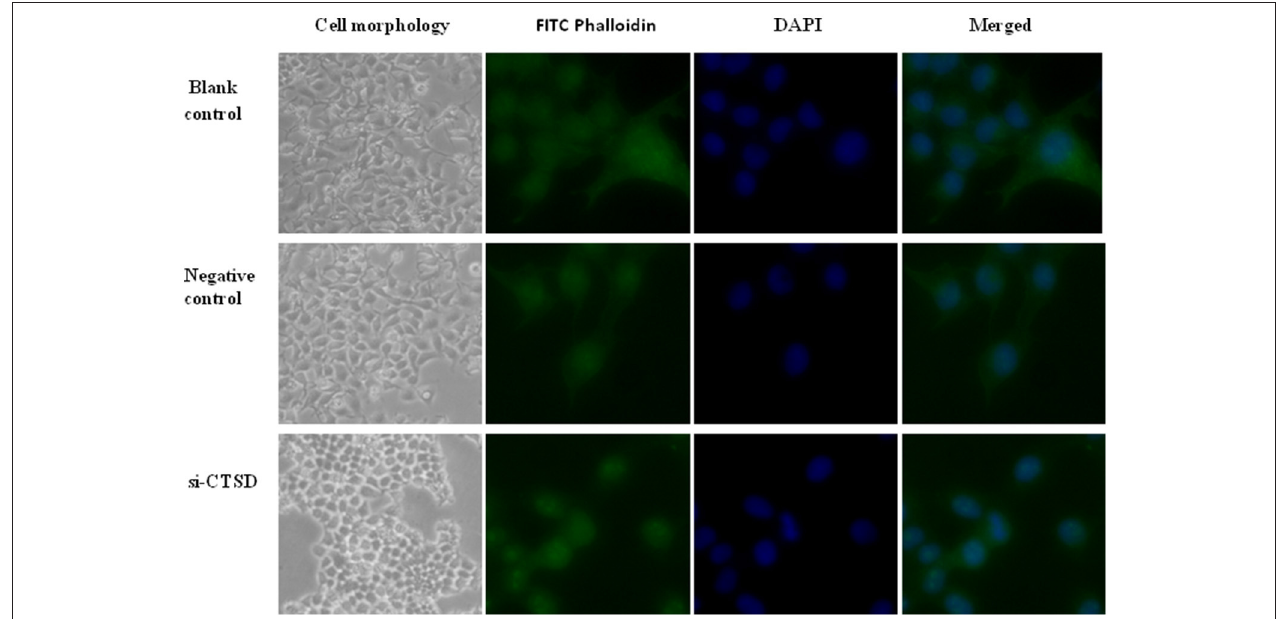
FIGURE 6 | Effect of CTSD on cytoskeletal organization in SACC-LM cells. siRNA-mediated CTSD silence resulted in morphological changes ranging from a migratory, fibroblastoid phenotype toward epithelial plasticity of SACC-LM, (100 × ). And FITC-phalloidin staining showed that siRNA-mediated CTSD silence led to a collapse in cytoskeletal organization and reduction in pseudo foot formation, (400 ×